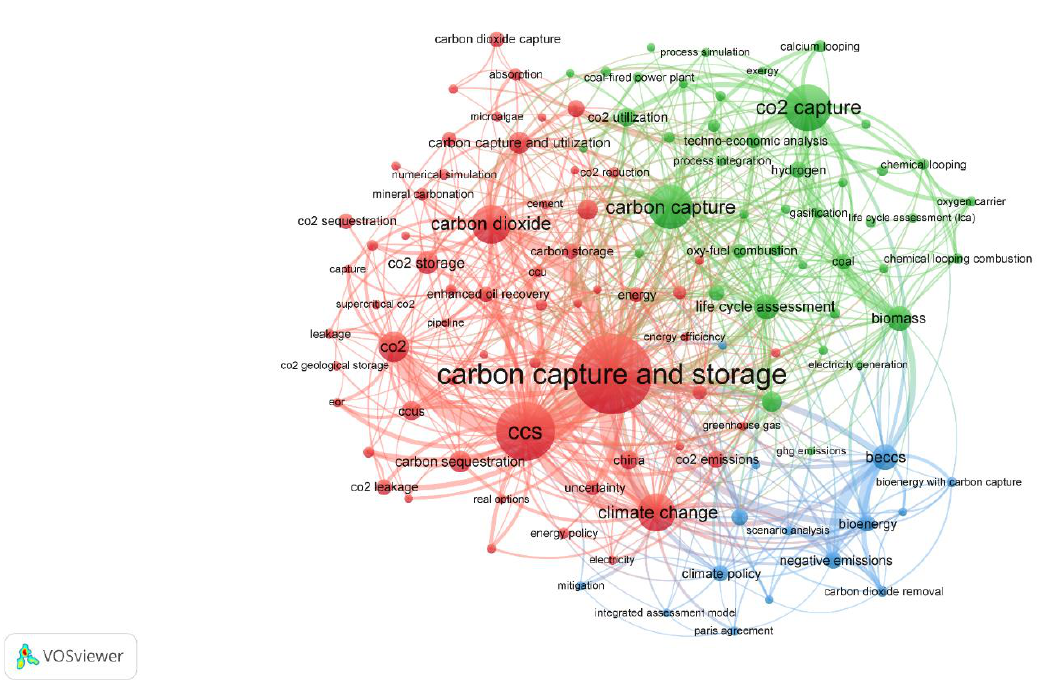
Figure 2. Map of clusters based on keyword analysis using VOSviewer.